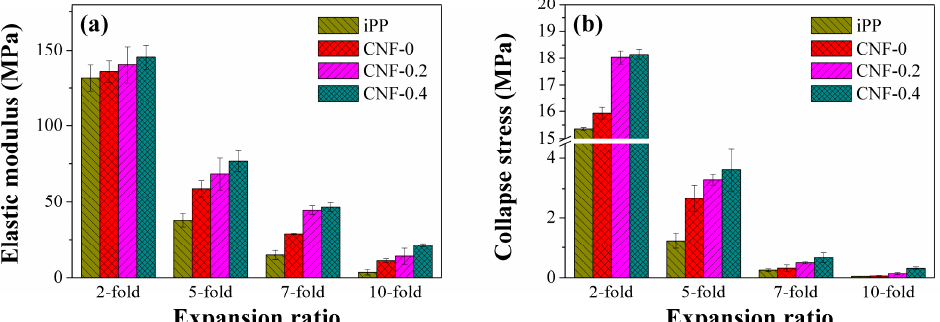
Figure 10. Change of ( a ) elastic modulus and ( b ) collapse stress for the iPP and PP/CNF nanocomposite foams as a function of the expansion